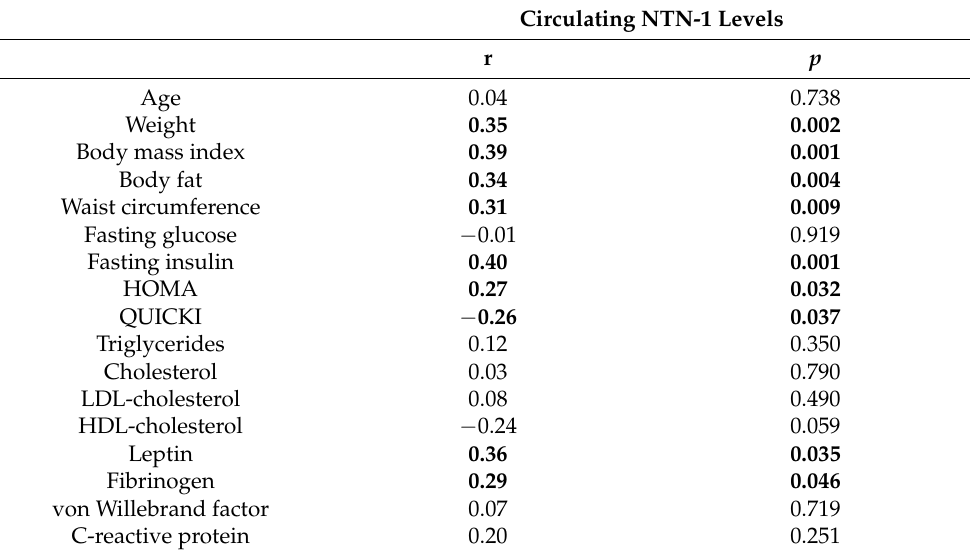
Table 2. Association between circulating concentrations of NTN-1 with anthropometric and biochem- ical characteristics.